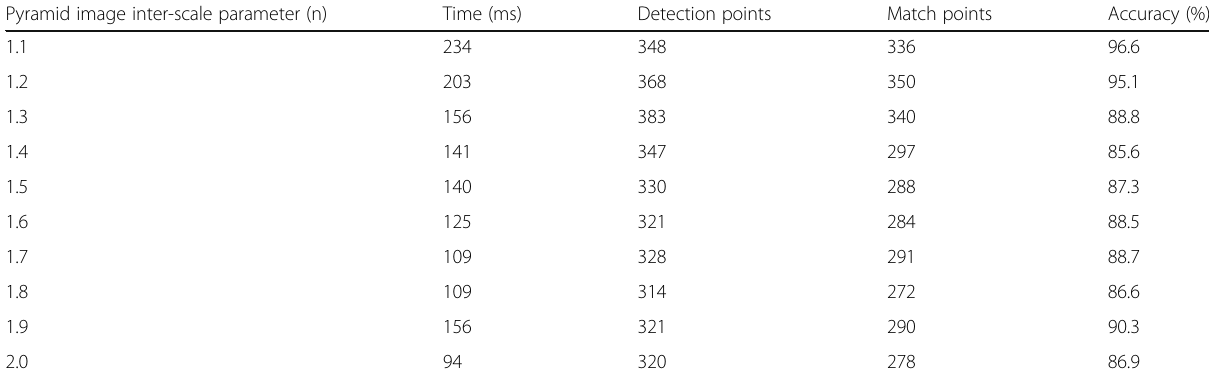
Table 3 Statistics table of the results of the scale parameter of the image when the pyramid layer is 8 Pyramid image inter-scale parameter (n)